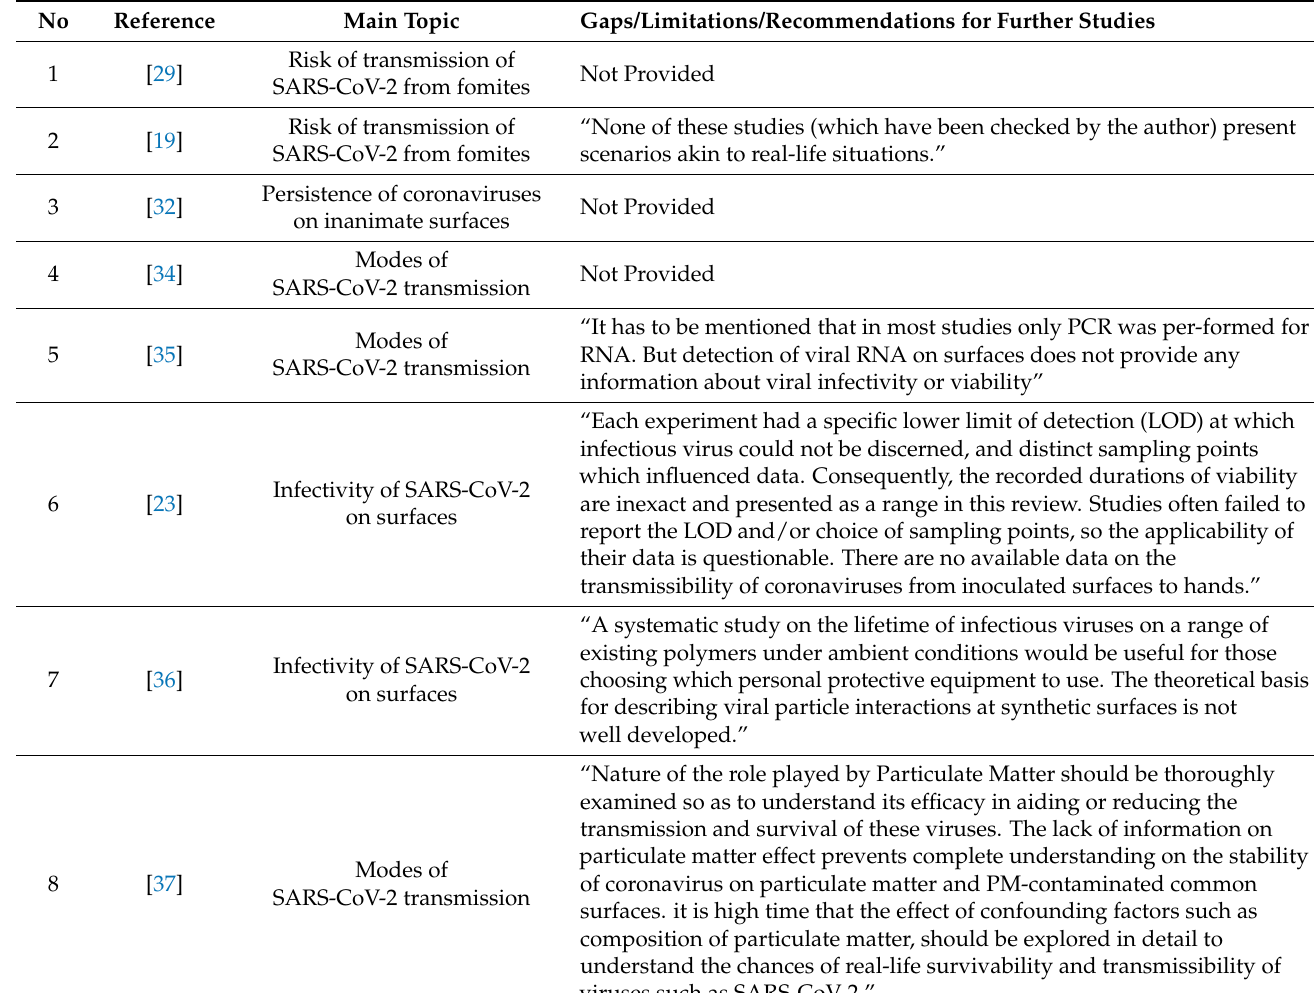
Table A3. Recommendations and limitations of review